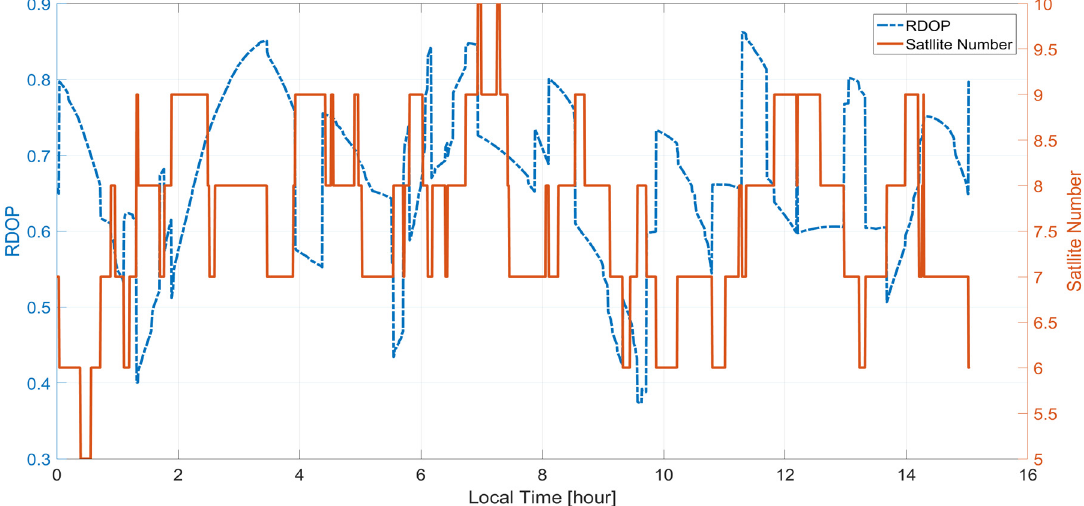
Table 2. The RMS and STD of the positioning error.